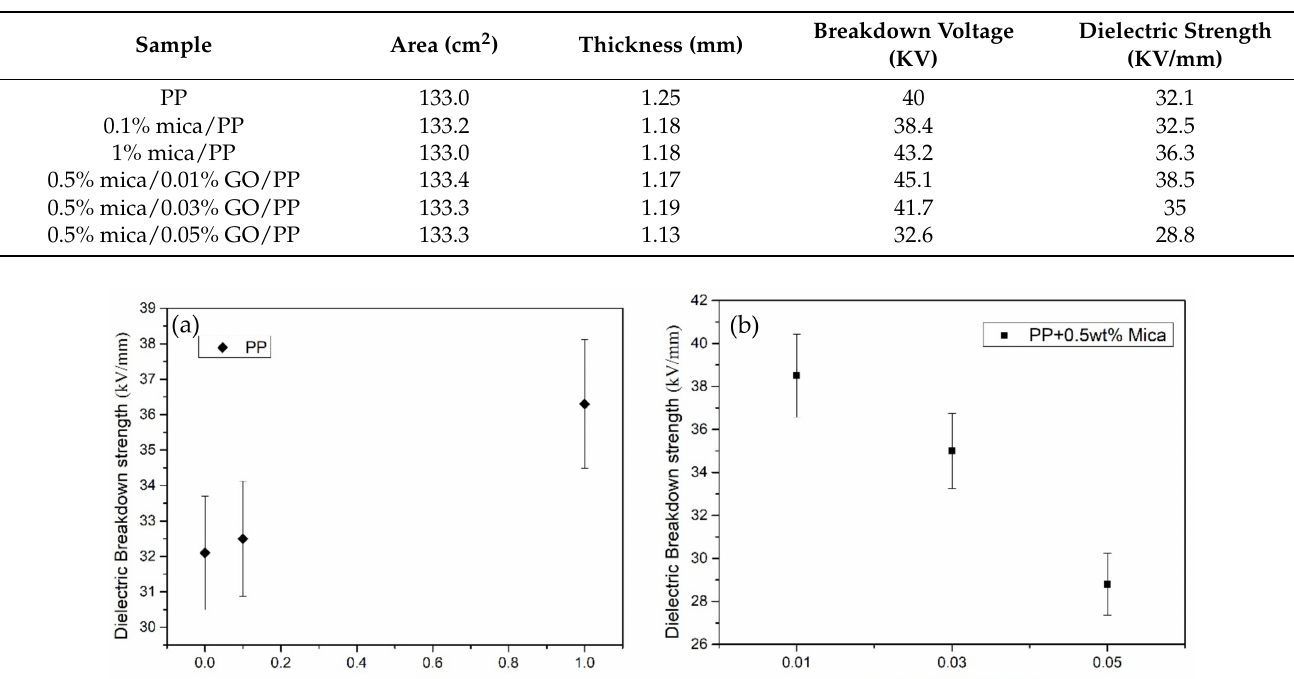
Table 2. Dielectric strength of PP with different proportions of mica and graphene oxide.